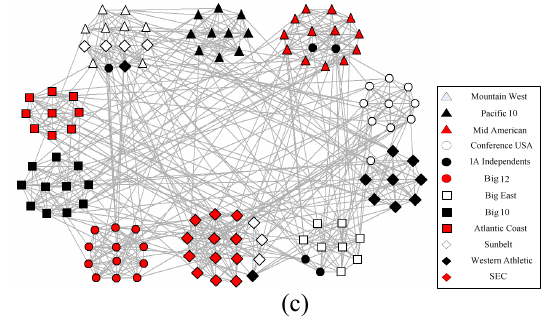
Fig. 8. (Color online) Clustering solutions of GALS on three widely used real-world networks with a known community structure. (a) Clustering solution of karate network; (b) Clustering solution of dolphin network; (c) Clustering solution of football